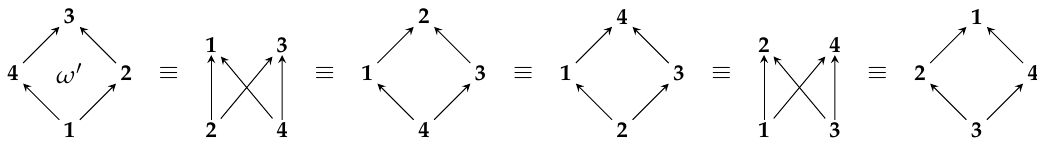
Figure 6. The six torically equivalent orientations to ω (cid:48) ∈ Acyc ( C 4 ) , shown at left.